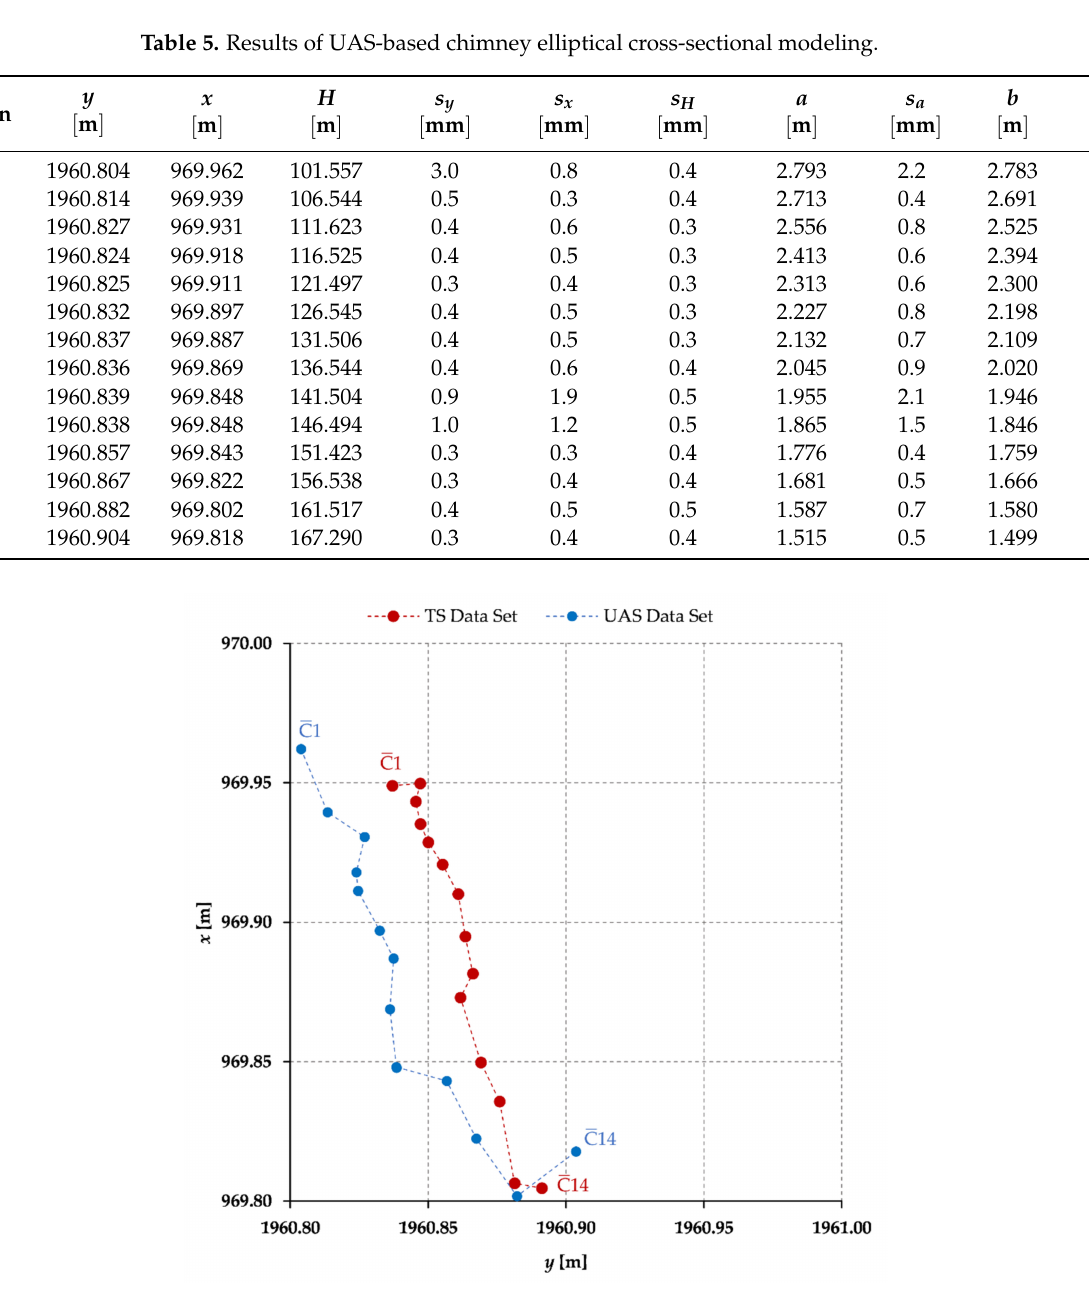
Figure 7. A 2D ( yx -plane) visualization of the cross-sectional ellipse centers of the TS-based data set (red) and UAS-based data set